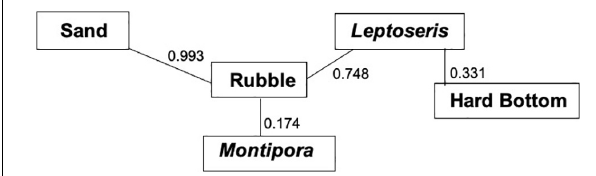
FIGURE 6 | Multi-response permutation procedure (MRPP) relationships for benthic habitat categories. Connected benthic habitat types are not significantly different from one another in terms of their fish assemblages. P -values between the benthic habitat categories are next to the connecting lines.